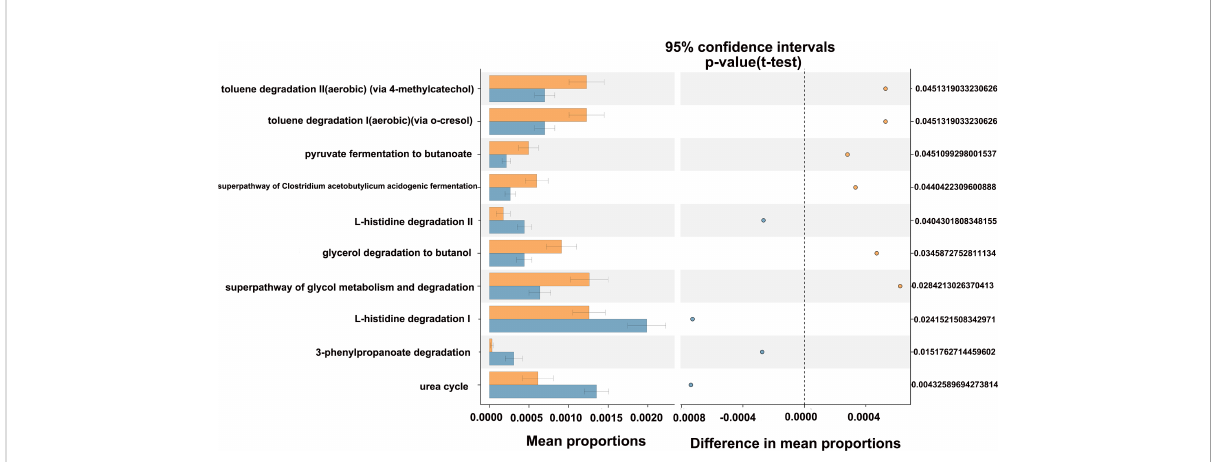
FIGURE 10 The difference in the KEGG pathways of gut microbiota between HIV+PCP+ and HIV+PCP- patients. PCP_neg_f: HIV+PCP- group; PCP_pos_f: HIV+PCP+ group.